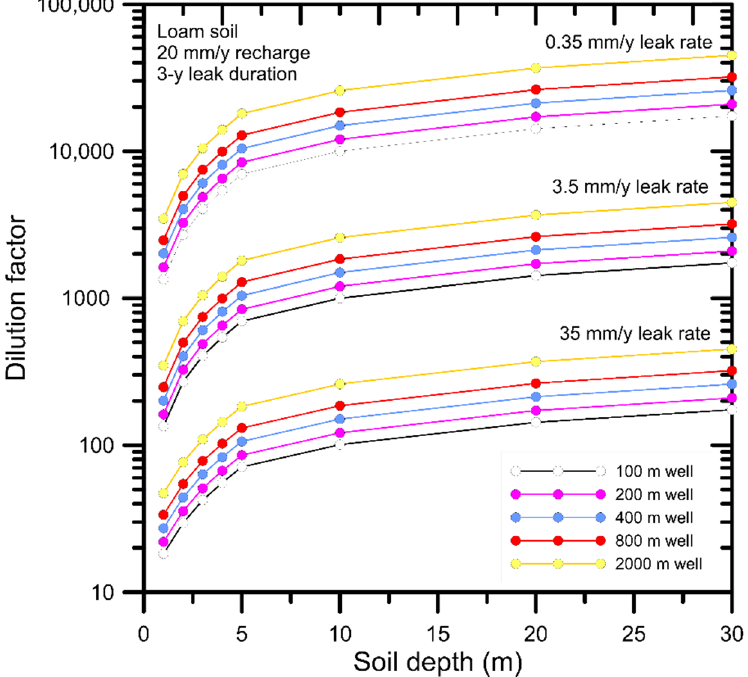
Figure 7. Combined dilution factor ( DF ) for loam soil and groundwater. Reference groundwater conditions used.